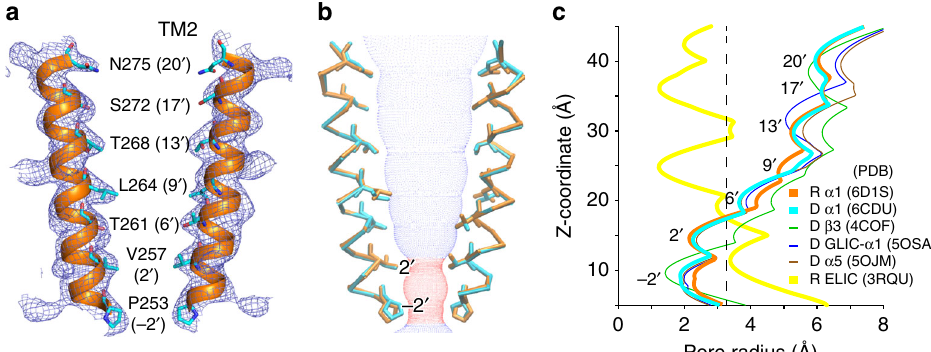
Fig. 3 Crystal structures of the pore of the ELIC- α 1GABA A R chimera. a Pore lining residues in the TM2 helices of the apo α 1GABA A R chimera covered by the 2 F O – F C electron density map contoured at 1 σ (blue mesh). b Overlaid structures of the pore-lining TM2 helices from apo (orange) and alphaxalone- bound (cyan) α 1GABA A R chimeras. Blue and red dots de fi ne apo α 1GABA A R chimera pore radii greater or less than the radius of a hydrated Cl − ion (3.2 Å), respectively. c Comparison of the pore radii of the α 1GABA A R chimera in the apo (orange) and desensitized states (cyan) to the desensitized β 3GABA A R (green), the desensitized GLIC- α 1GABA A R chimera (blue), the desensitized α 5GABA A R chimera (brown), and resting ELIC (yellow)